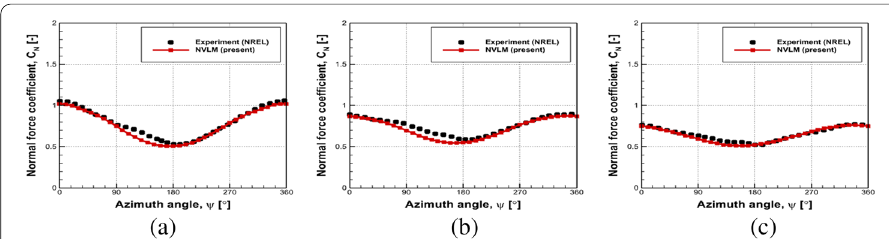
Fig. 13 Azimuthal variation of normal force coefficient acting at specific radial positions for V β 30º: ( a ) r/R 0.47, ( b ) r/R 0.63, and ( c ) r/R = = =